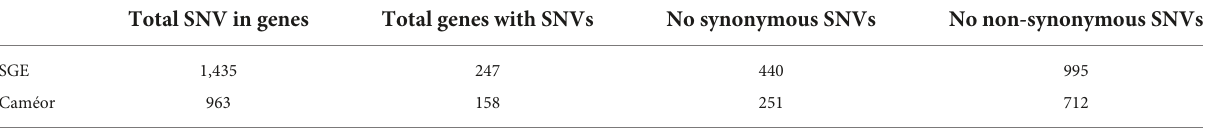
TABLE 2 Analysis of SNVs in SGE and Caméor NCR genes as compared to Frisson. Total SNV in genes Total genes with SNVs No synonymous SNVs No non-synonymous SNVs